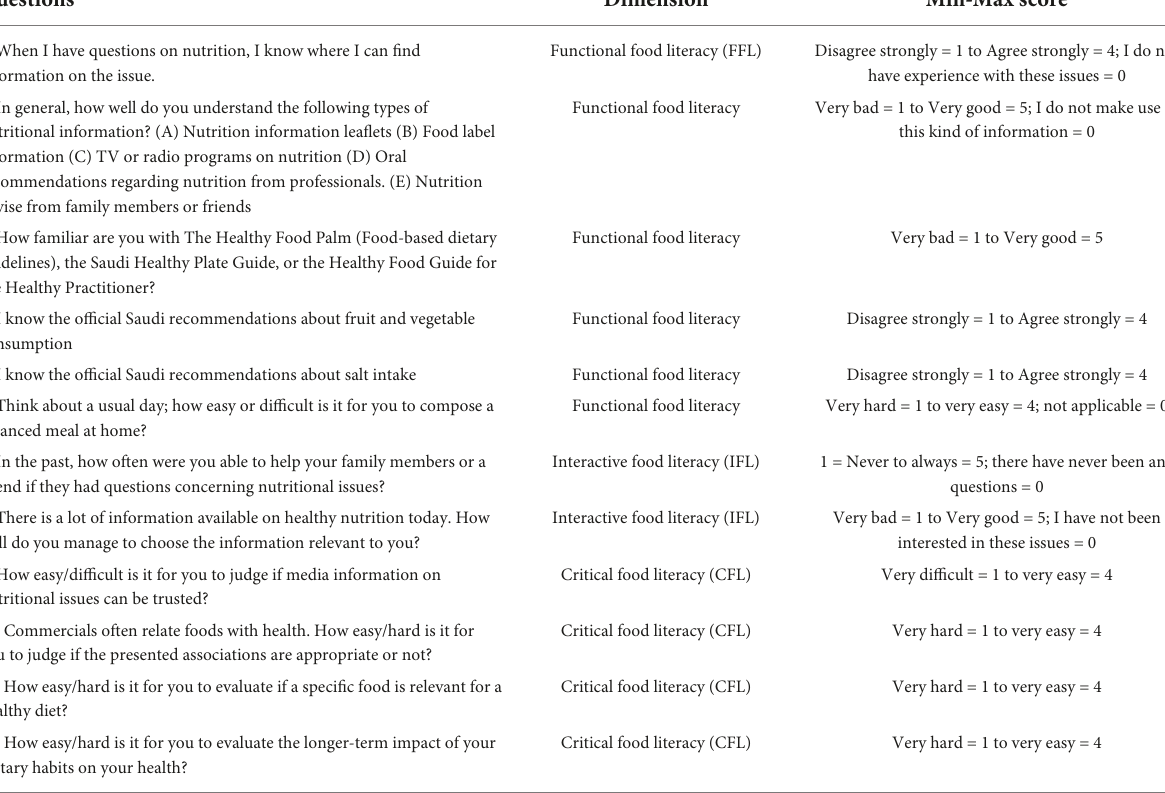
TABLE 1 Parental self-rated food literacy